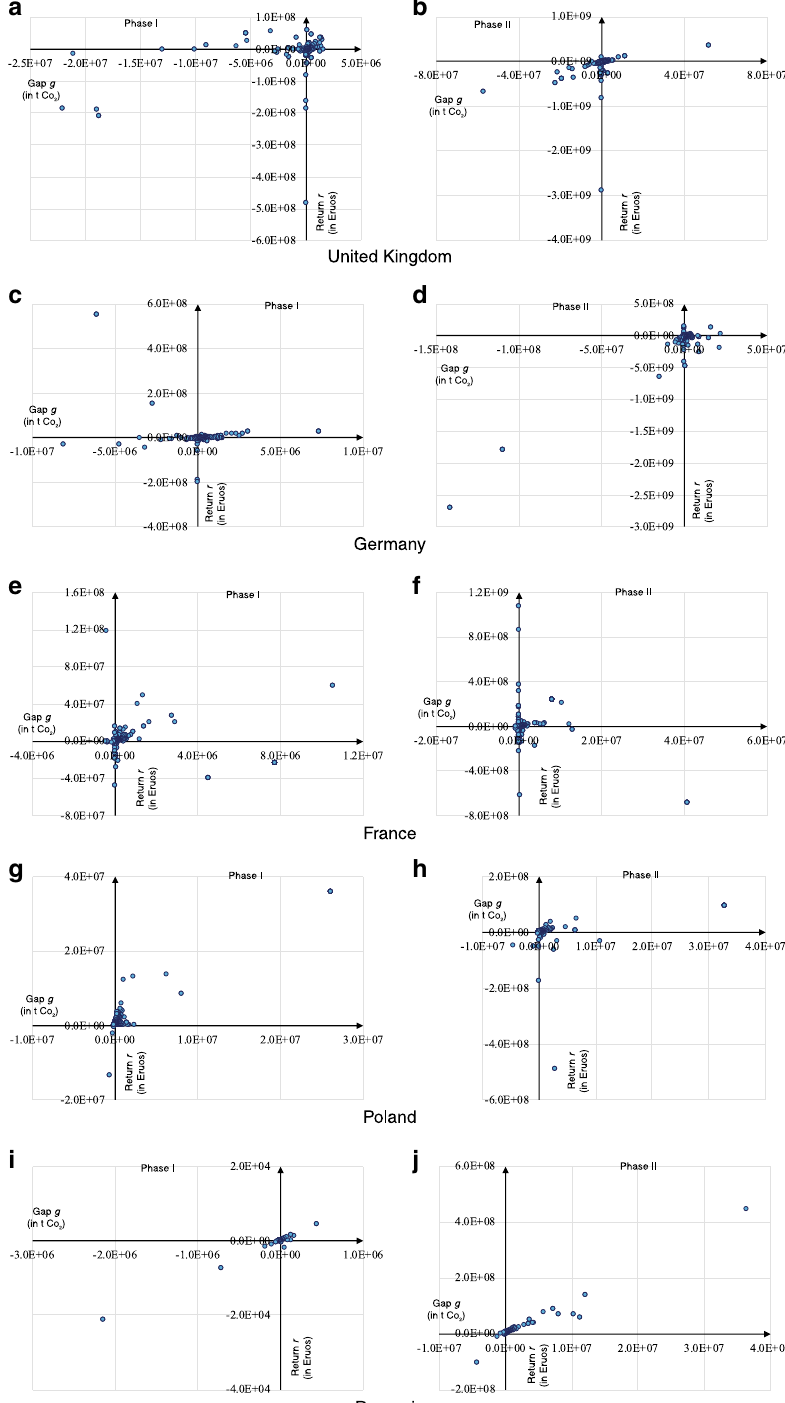
Fig. 5 State-level trading performance of the abnormal states. By grouping the fi rm-level trading data into states, there are fi ve states, namely United Kingdom, Germany, France, Poland, and Romania, abnormally performed in the EU ETS. The Phase I performance of these states is plotted on the left side of the fi gure ( a , c , e , g , and I , respectively). The Phase II performance is plotted on the right side ( b , d , f , h , and j ,